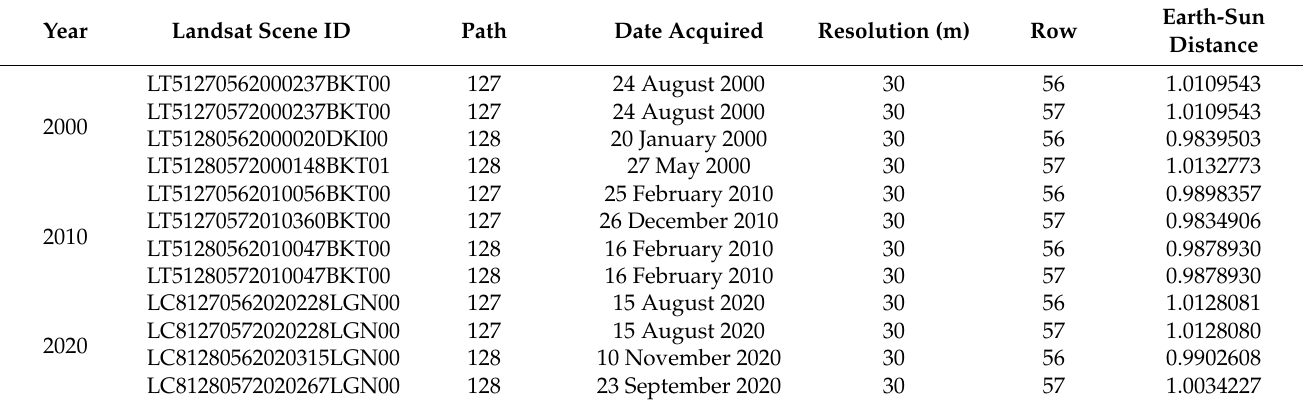
Table 1. Detailed data for the Landsat images used for the study